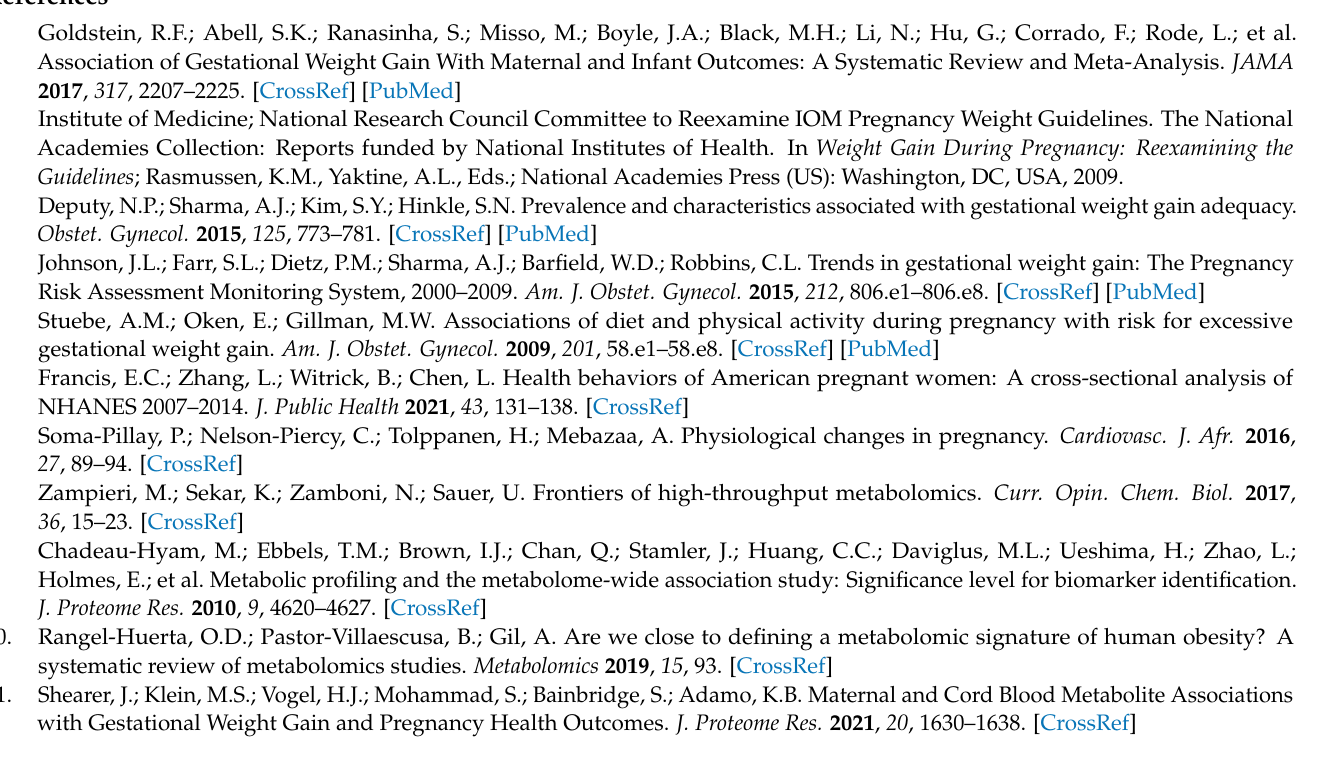
Table S4: Associations of 186 metabolites at 32 weeks of gestation with gestational weight gain in linear regression analyses; Table S5: Associations of 47 changes of metabolites from baseline to 32 weeks of gestation with gestational weight gain in linear regression analyses; Figure S1: Principal component analysis score plot of the first two principal components of 29 pregnant women based on their metabolites collected around 32 weeks of gestation; Figure S2: Dendrogram of the analyzed metabolites by superclass and class, for which the classification of chemical compound was performed using ClassyFire. STROBE Statement for cohort studies was